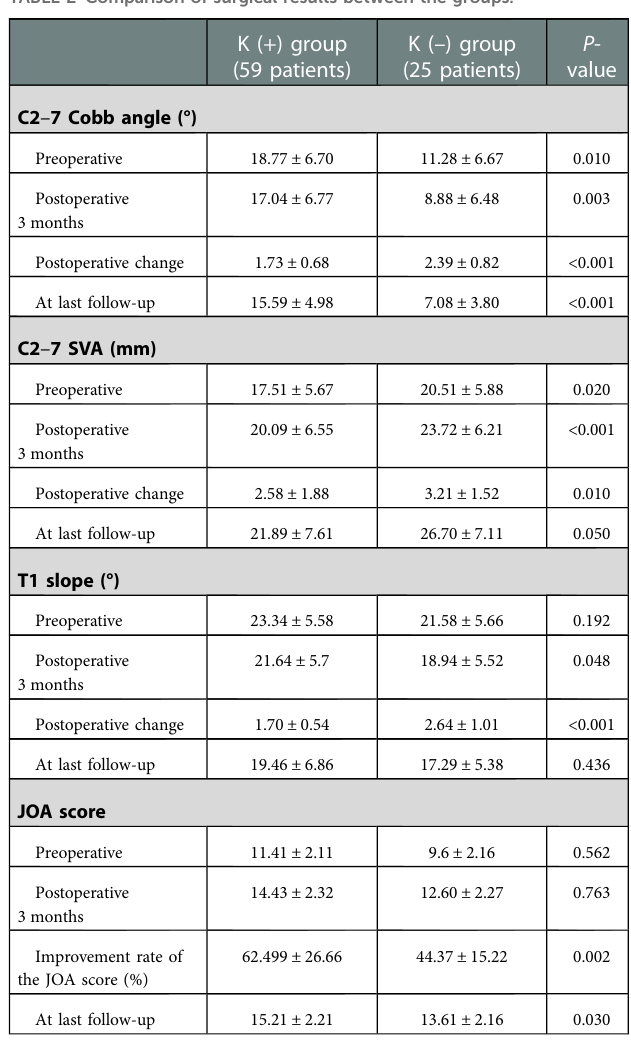
TABLE 2 Comparison of surgical results between the groups.